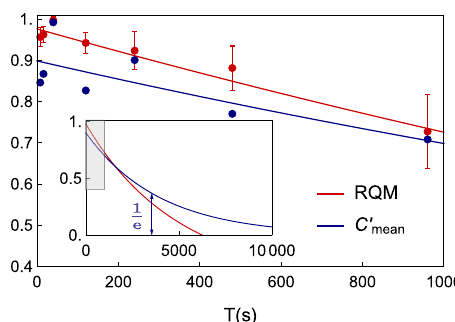
Fig. 5 Benchmark of quantum memory and coherence. Red and blue points are data of the robustness of quantum memory (RQM) and the mean ratio of the relative entropy of coherence (REC), respectively. Error bars are standard deviations. The red line is the theoretical result of the RQM calculated from the process matrix of Eq. (1) and the blue line is the exponential fi tting result of the mean ratio of the REC. Inset shows extrapolations of fi ts in a longer time range. The shadow indicates the enlarged area in the fi gure. The blue vertical line indicates the time point when the mean REC ratio decays to 1/ e